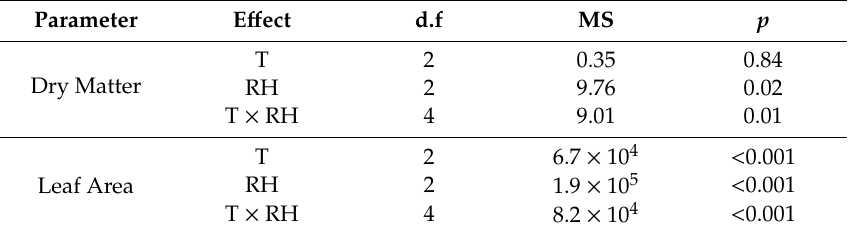
Table 2. Analysis of variance for plant dry matter and plant leaf area under di ff erent day and night temperature and RH regimes around the same daily mean temperature (25 ◦ C) and RH (65%) in 3 replications. Abbreviations: T: temperature; d.f.: degree of freedom; MS: mean square. Parameter E ff ect d.f